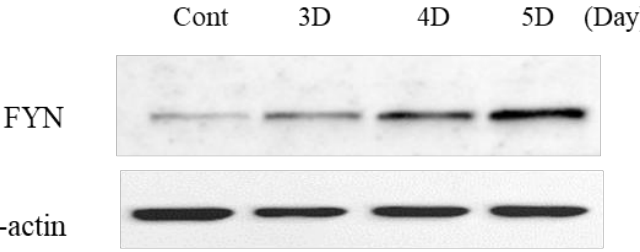
Figure 12. Expression of PLXNA4-dependent semaphorin signaling molecules in human umbilical- cord-derived mesenchymal stem cells by low-intensity sub-sonic vibration using real-time polymerase chain reaction analysis. Cells were harvested 4 days after low-intensity sub-sonic vibration treatment. SEMA3A : Semaphorin 3A, SEMA6A : Semaphorin 6A. Column heights correspond to mean values and error bars to standard deviations ( n = 3).